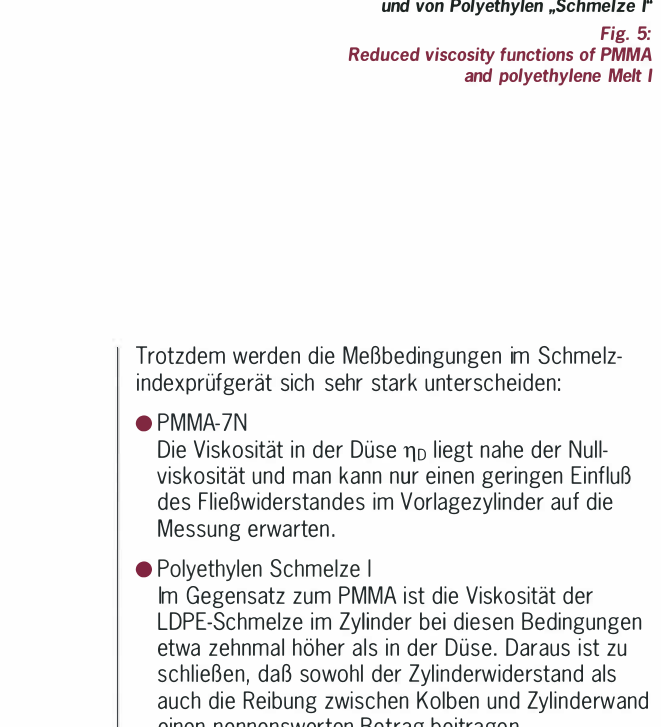
Reduced viscosity functions of